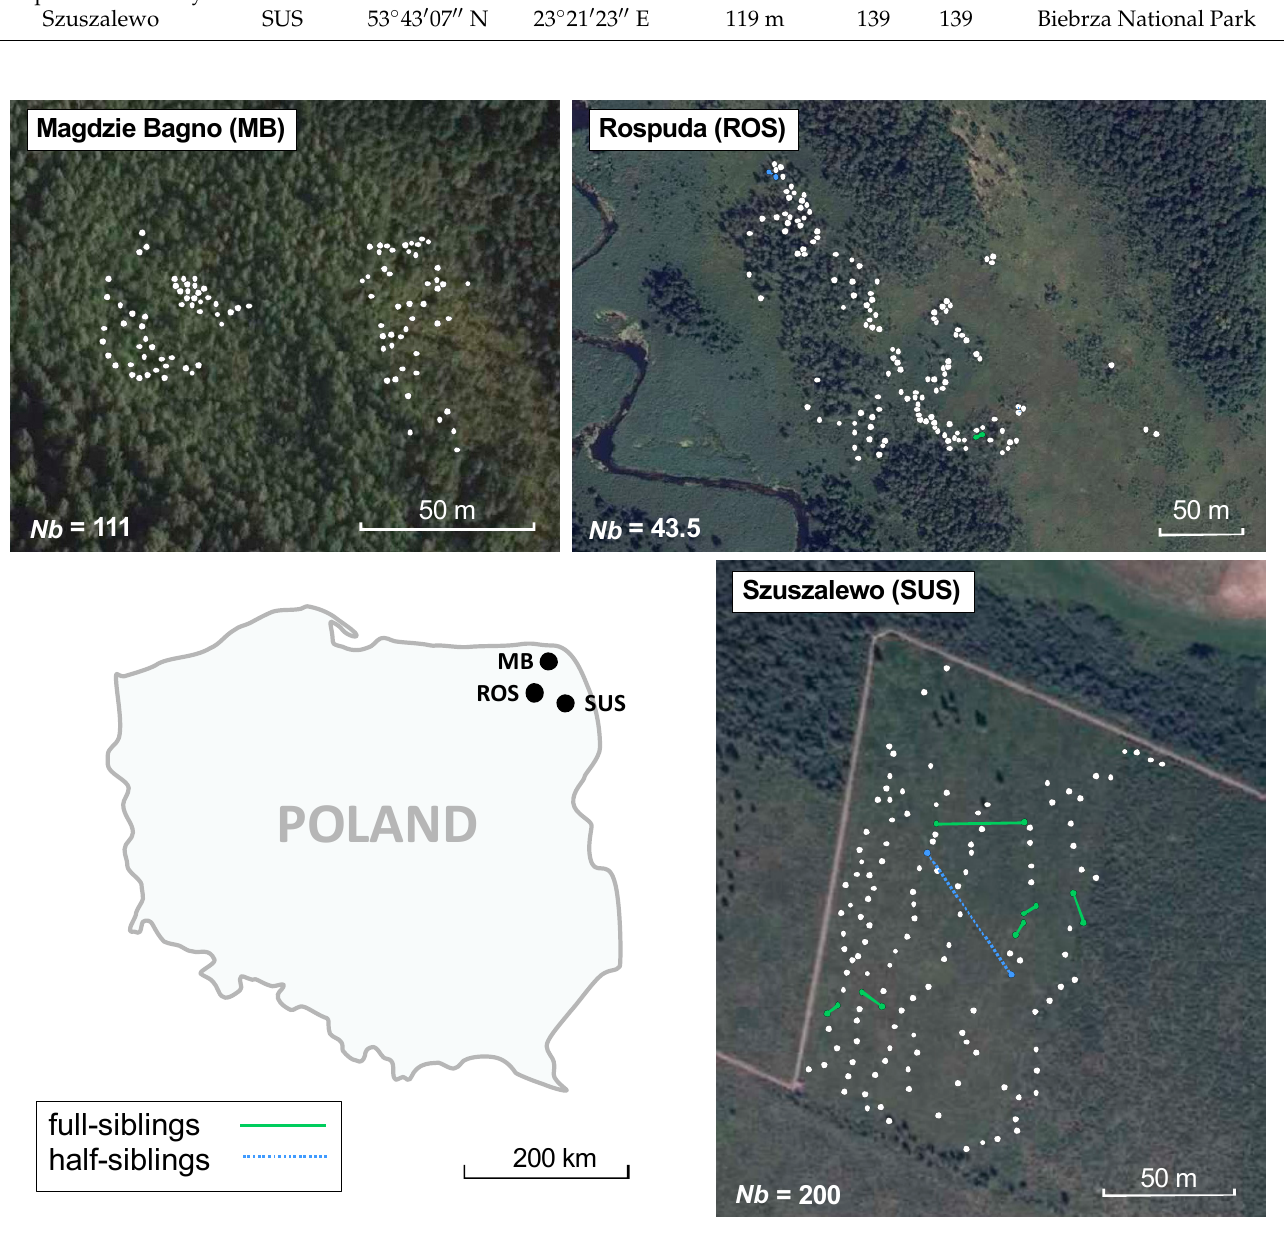
Figure 1. Location of the studied B. humilis populations and the spatial distribution of individuals at each site. Nb —neighbourhood size. Orthophotomaps were acquired from the site geoportal.gov.pl. (accessed on 16 August